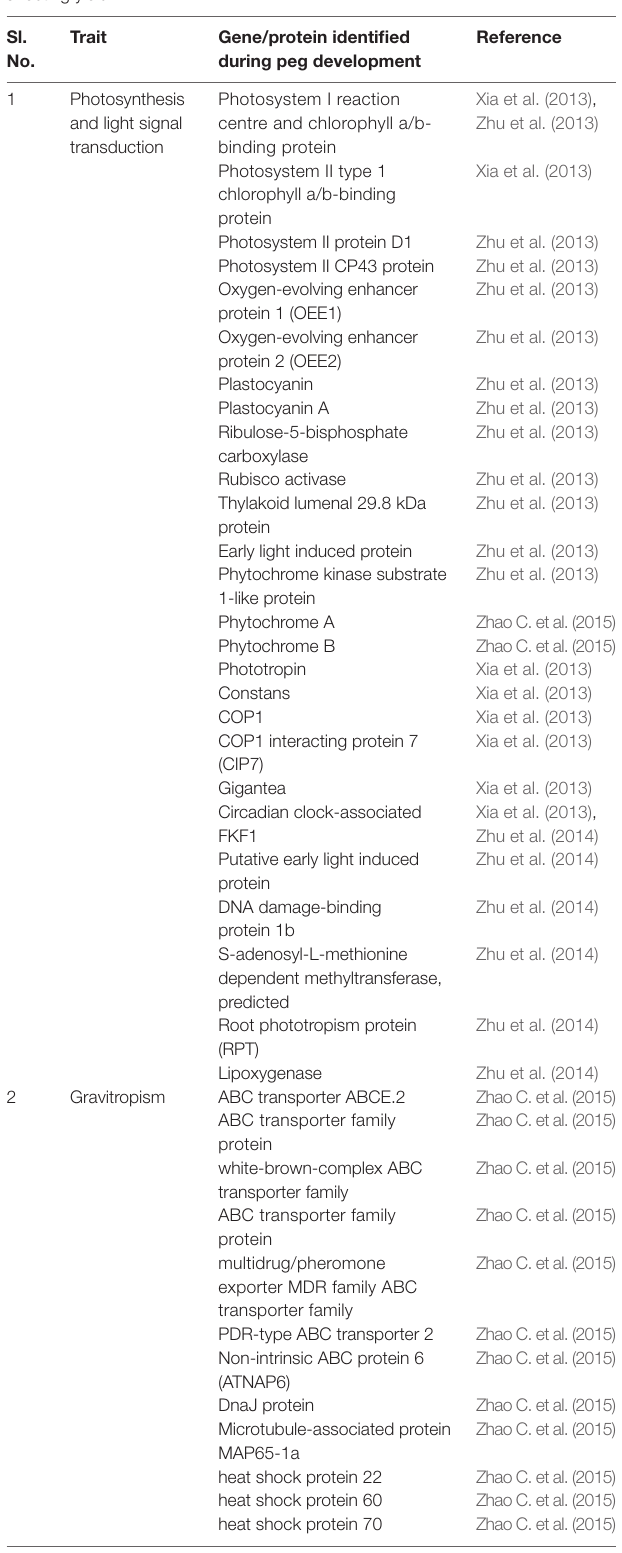
TABLE 1 | List of important genes regulating peg development and consequently affecting yield. Sl.